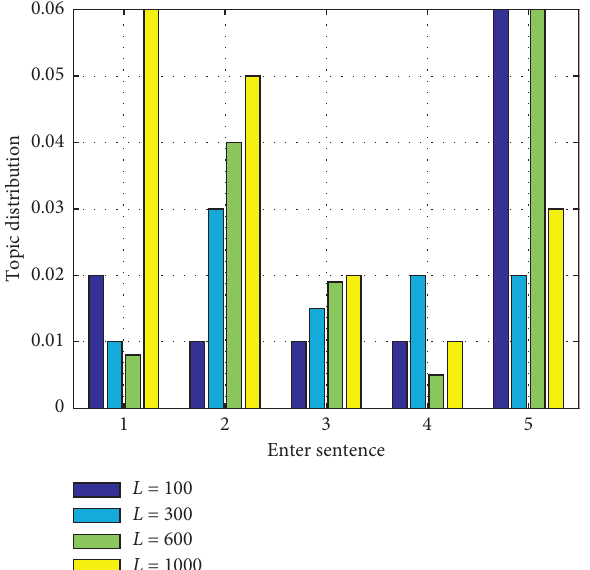
Figure 9: Topic distribution information of three sentence candidates.